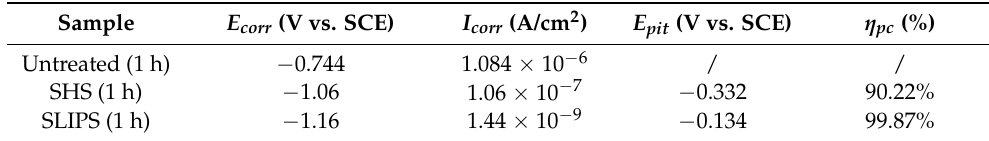
Figure 5. Polarization curves after immersion in simulated seawater for 1 h. Table 1. The characteristic parameters obtained from polarization curves after immersion in simulated seawater for 1